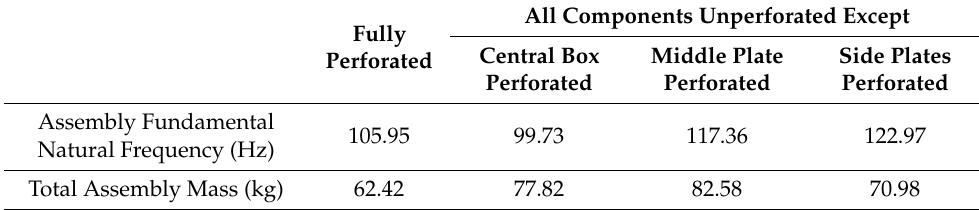
Table 5. Fundamental natural frequencies for the half scale triangles